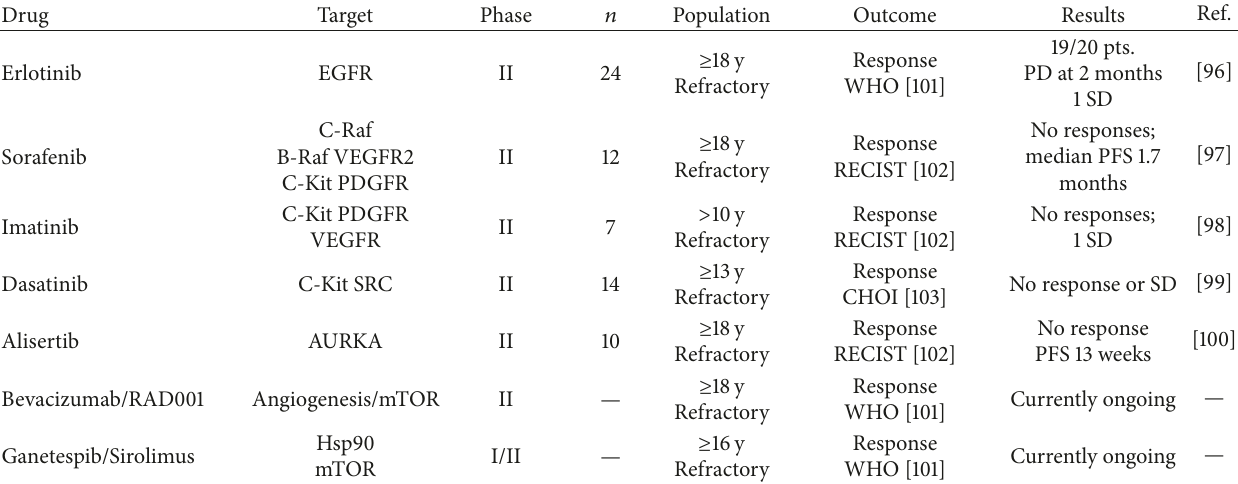
Table 3: Targeted agents for treatment of MPNST: previous and ongoing clinical